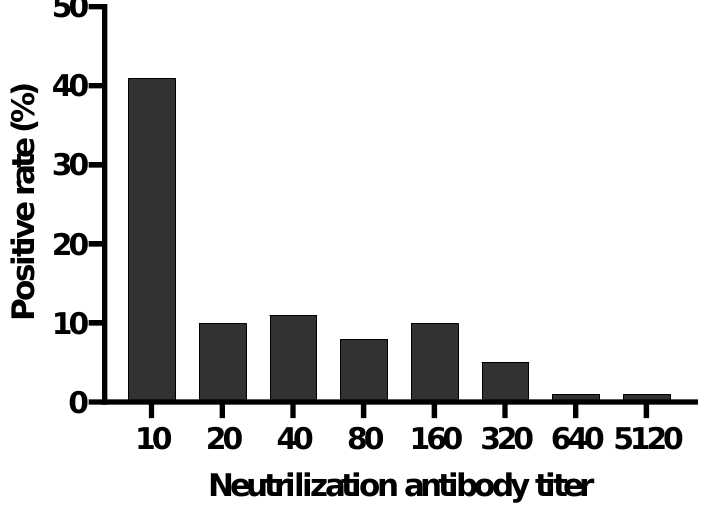
Figure 2. Proportion of anti-JEV neutralizing antibody titers among vaccinated students.